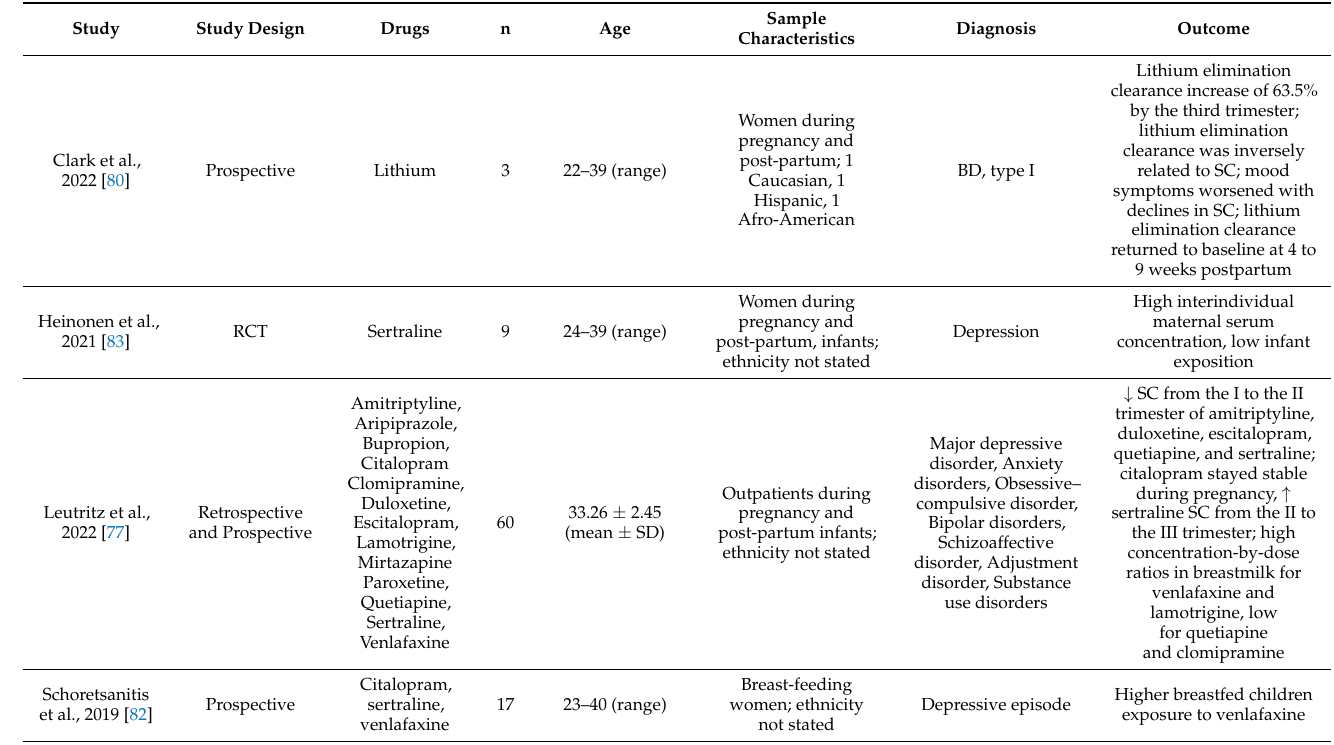
Table 5. Original articles on the use of TDM during